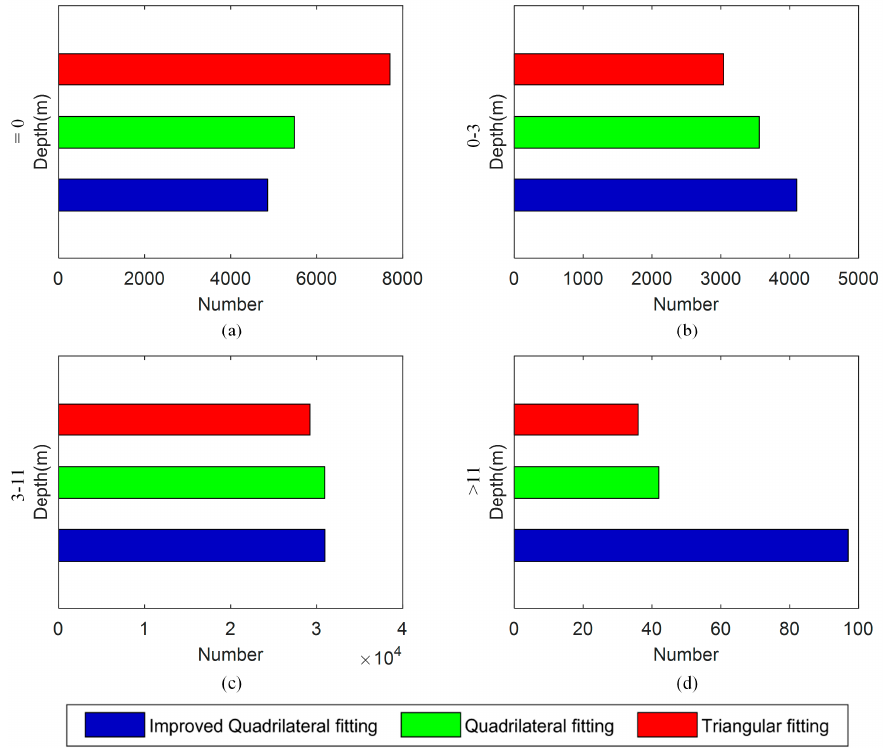
Figure 6. The bathymetry distribution of the detected waveform numbers for the three algorithms: ( a ) Depth = 0 (m); ( b ) 0 < Depth ≤ 3 (m); ( c ) 3 < Depth ≤ 11 (m), and ( d ) Depth > 11 (m).